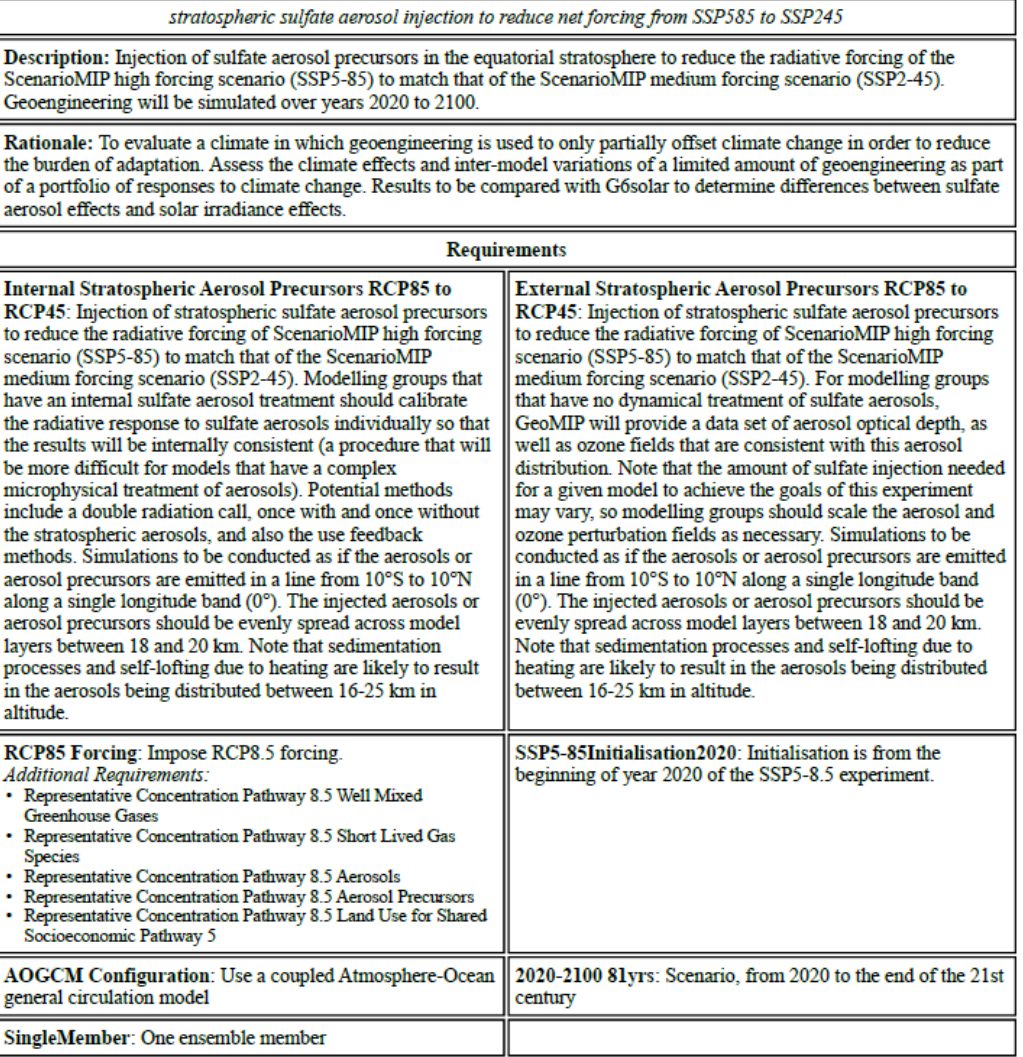
Table A4. GeoMIP is clear about what the forcing should achieve (reduction in radiative forcing from rcp8.5 to rcp4.5) but leave it open to the modelling groups to choose a method that best suits their aerosol scheme. See https://documentation.es-doc.org/cmip6/experiments/g6sulfur, last access: 2 March 2020, for more